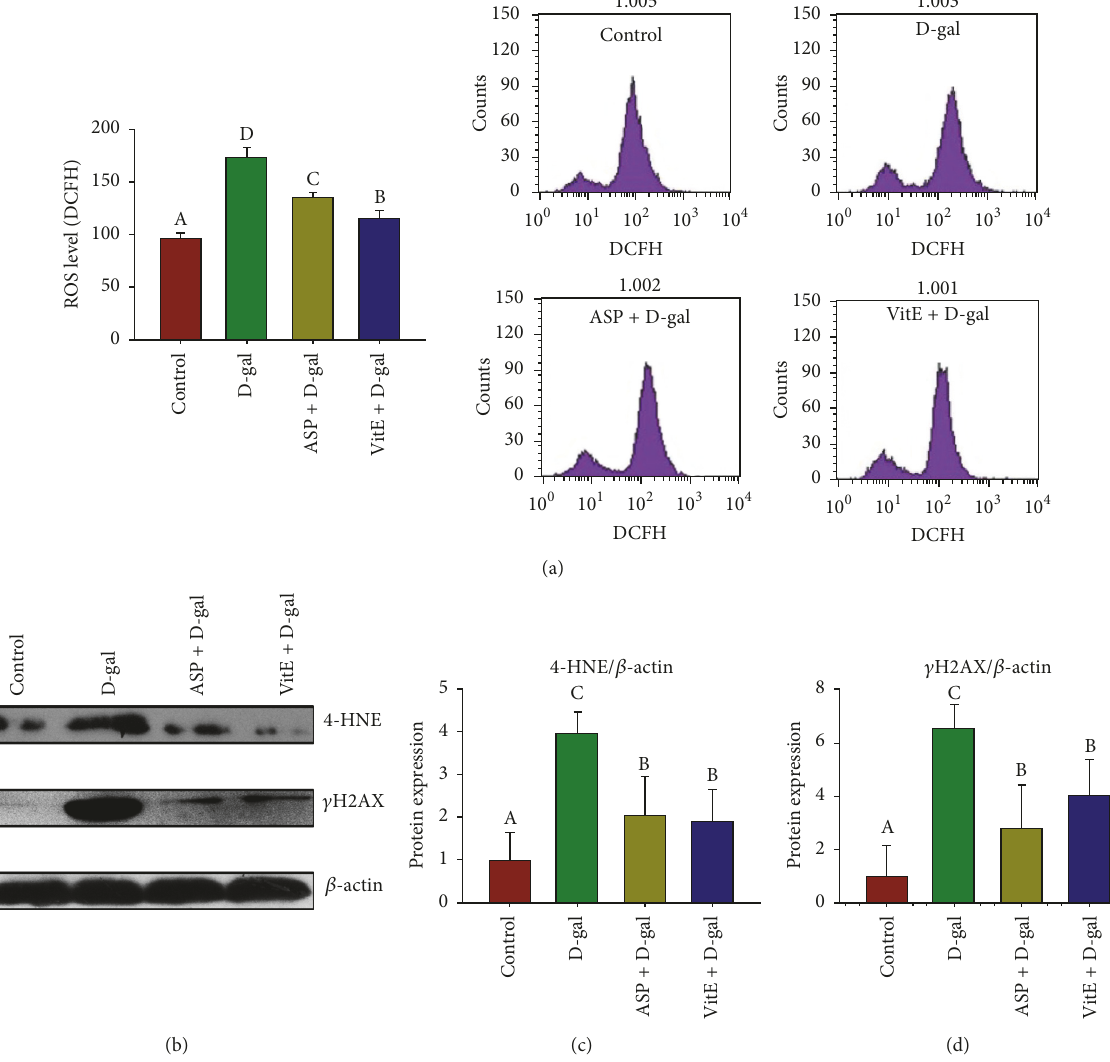
Figure 2: Effect of ASP on oxidative stress and DNA damage of Sca-1 + HSC/HPCs in D-gal-induced aging mice. The Sca-1+ HSC/HPCs were collected after the treatment. (a) The level of ROS was determined by DCFH fluorescence through flow cytometry. (b) The protein expression analyses of 4-HNE and 𝛾 H2A.X by Western blot, 𝛽 -actin was used as the internal control. (c) The relative protein expression of 4-HNE. (d) The relative protein expression of 𝛾 H2A.X. Different letters: 𝑃 < 0.05 .